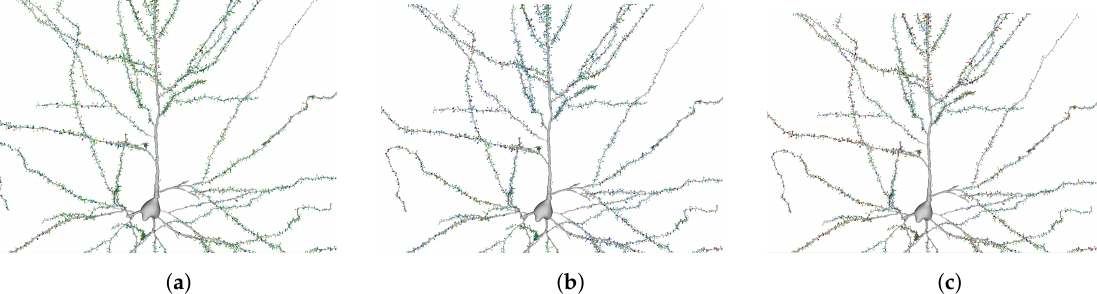
Figure 8. Spine comparison results from a human pyramidal neuron. ( a ) Maximum diameter and minimum mean neck diameter; ( b ) maximum mean neck diameter; ( c ) maximum membrane potential